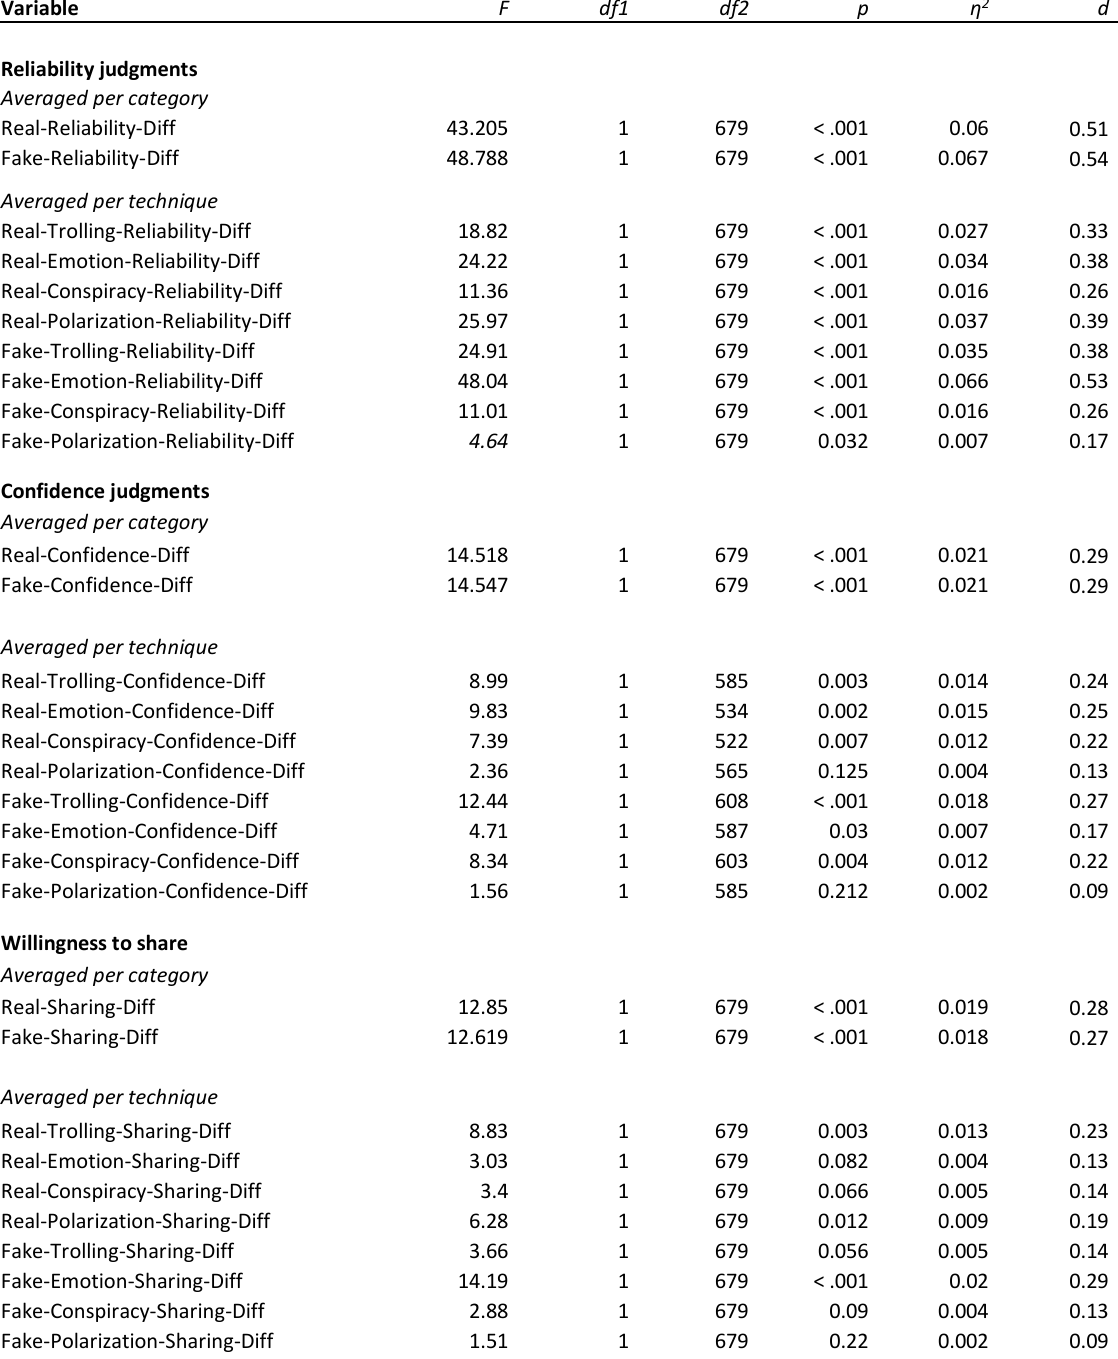
Appendix: Table S3: ANOVAs for difference scores, averaged by type and by each of the 4 manipulation